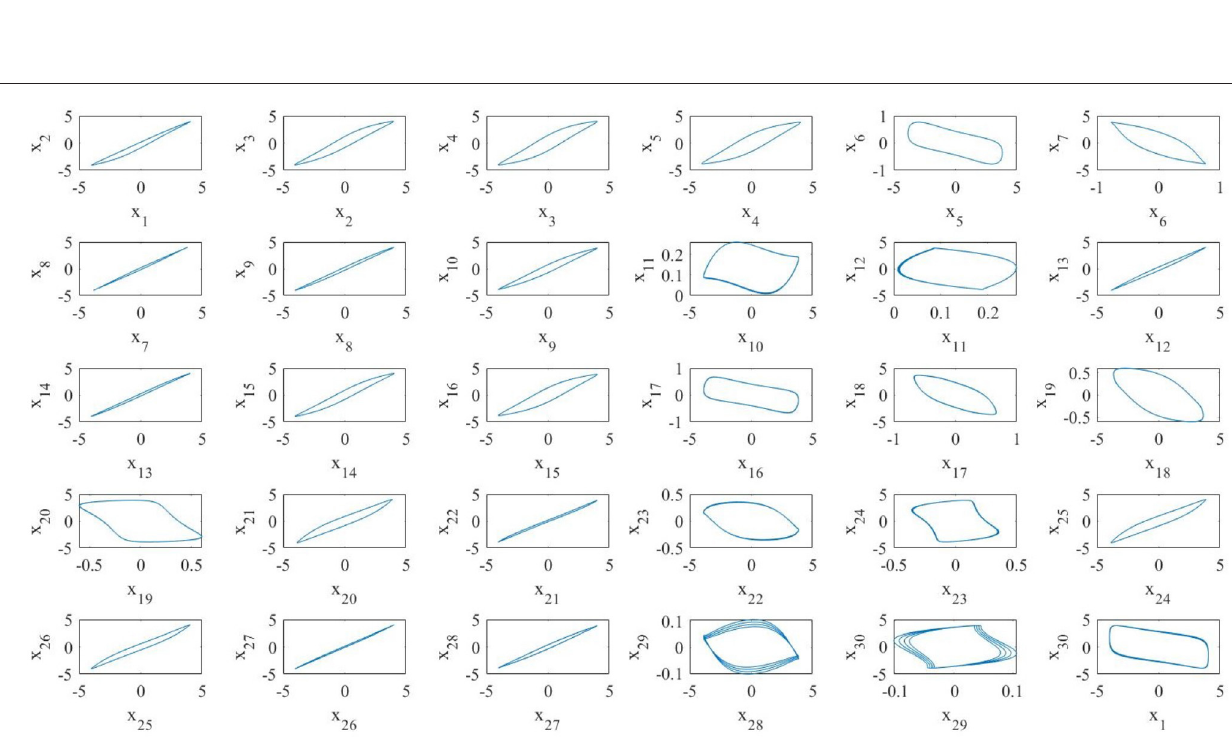
Frontiers in Neuroscience |